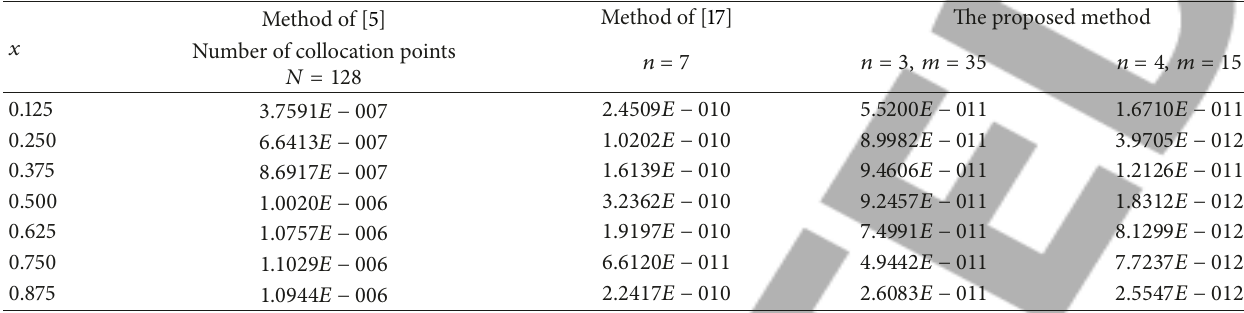
Table 2: Numerical comparison of absolute difference errors for Example 4.